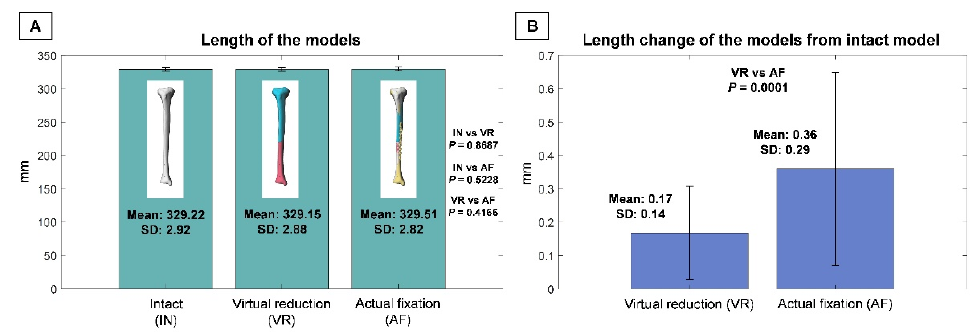
Figure 4. ( A ) Lengths of intact (IN), virtual reduction (VR), and actual fixation (AF) models. ( B ) Length variation of VR compared to IN and that of AF compared to IN. Standard deviation, (SD). The mean angulation of VR relative to IN was 0.39 ◦ (SD, 0.28 ◦ ; range, 0–0.92 ◦ ),